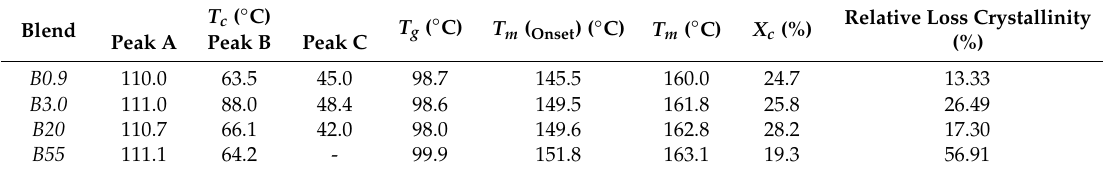
Table 5. Thermal characteristics for the PP / PS